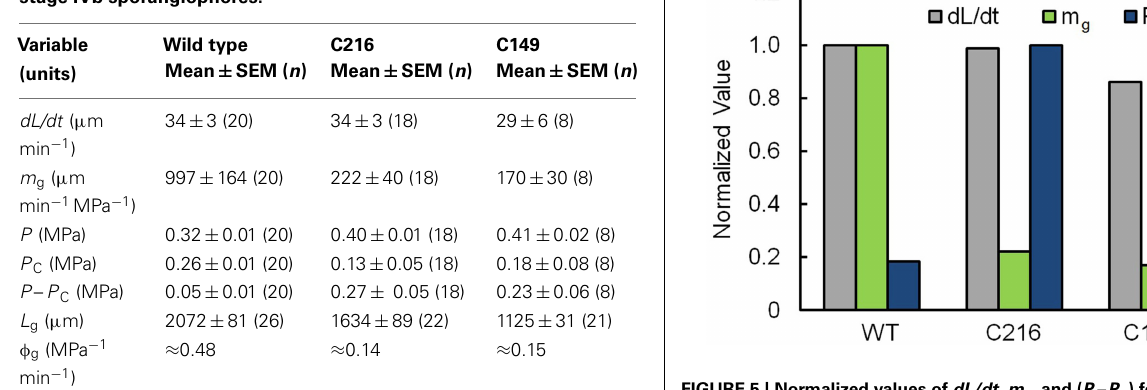
Table 1 | Biophysical variables forWT and stiff mutant (C216 and C149) stage IVb sporangiophores.